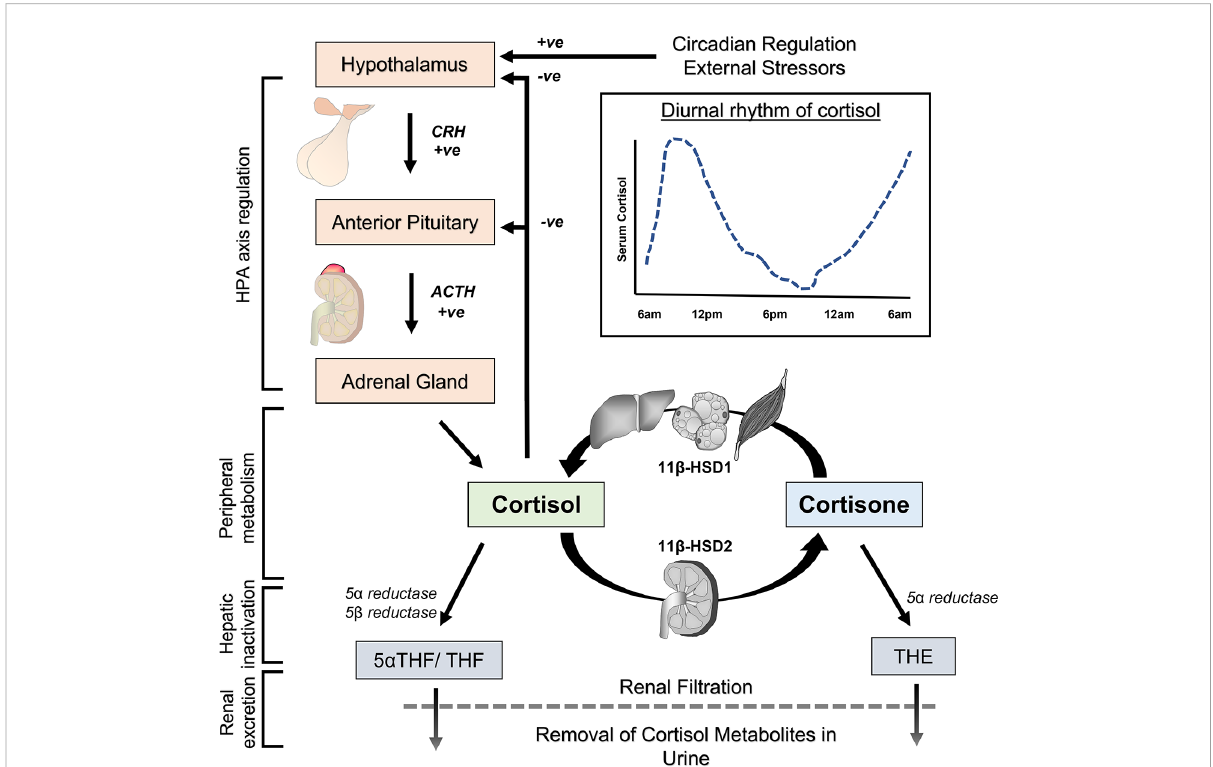
FIGURE 2 Pathways for physiological regulation of cortisol in the body. The hypothalamic-pituitary-adrenal (HPA) axis controls cortisol synthesis in the adrenal gland and its release into the circulation. The activity of the HPA axis is set by the circadian clock, negative feedback from circulating cortisol, external stressors and other factors. Cortisol and inactive cortisone are interconverted by 11 b -hydroxysteroid dehydrogenase (11 b - HSD) enzymes for reversible activation and inactivation in peripheral tissues. Liver, fat and skeletal muscle are predominant sites of cortisol activation by 11 b -HSD1, while kidney is the predominant site for reversible cortisol inactivation by 11 b -HSD2. Terminal inactivation of cortisol occurs in the liver through enzymatic reduction to tetrahydrocortisol (THF), 5 a -tetrahydrocortisol (5 a -THF) and tetrahydrocortisone (THE). These metabolites are ultimately removed from the body through fi ltration in the kidneys and excretion in